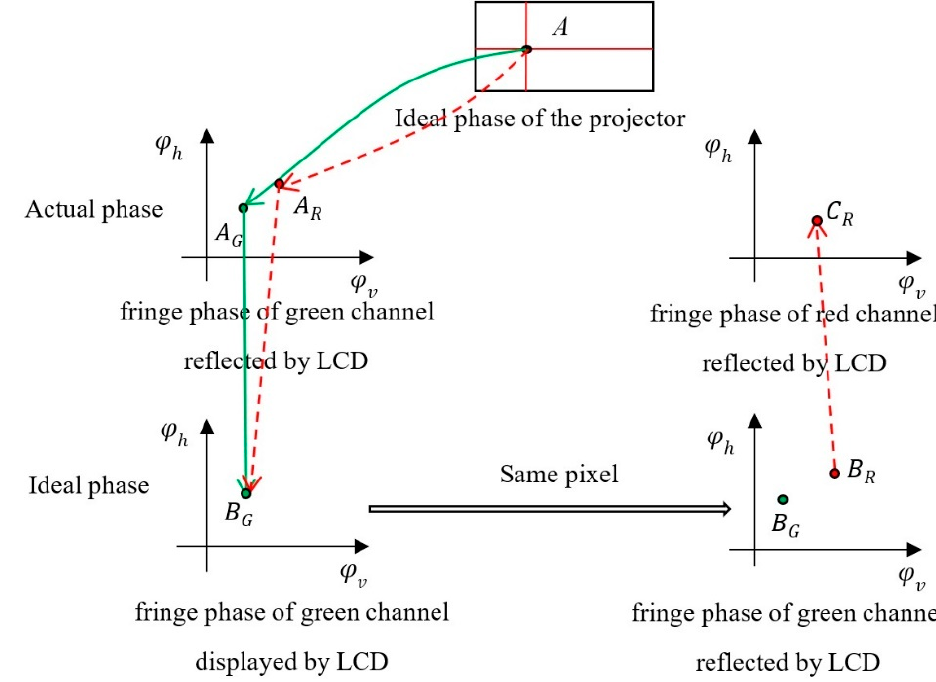
8 of 18 Figure 5. Flow chart of radial chromatic aberration correction. The specific process is as follows: 1.